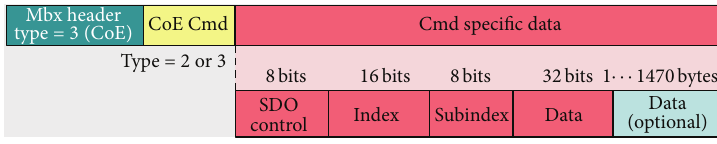
Figure 17: CANopen over EtherCAT devicearchitecture (slide 131 of